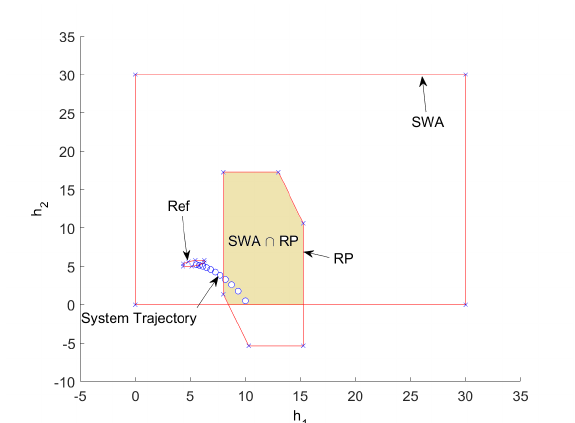
Figure 6. A two-tank system simulation.